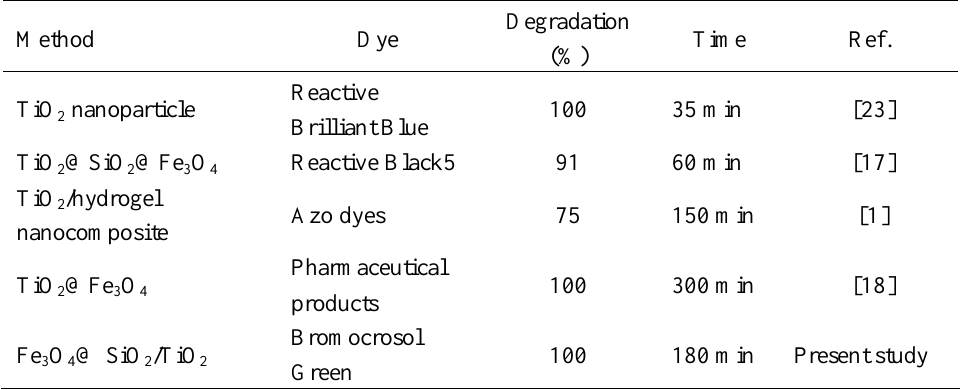
Table 1. Comparison Between the Proposed Method and other Reported Techniques for